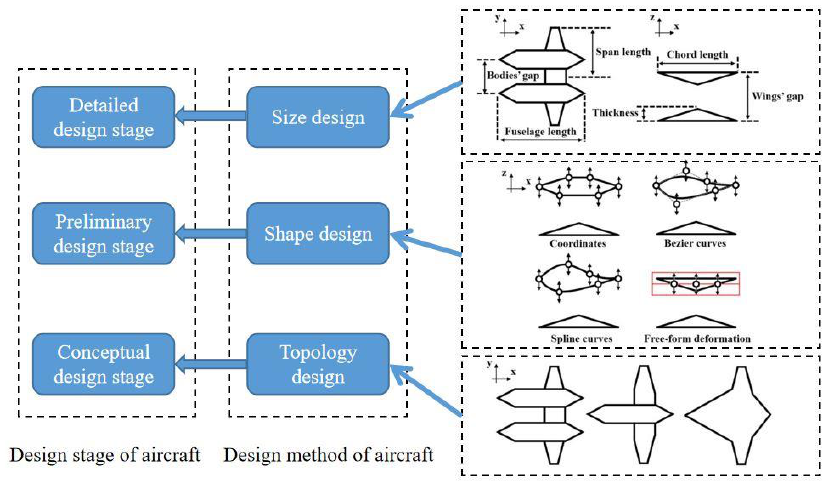
Figure 1. Relationship between optimization methods and design stages [1].